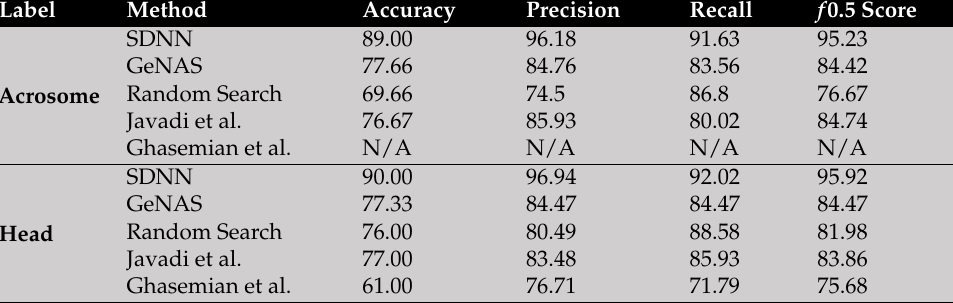
Table 7. Comparison of the latest proposed models with the SDNN